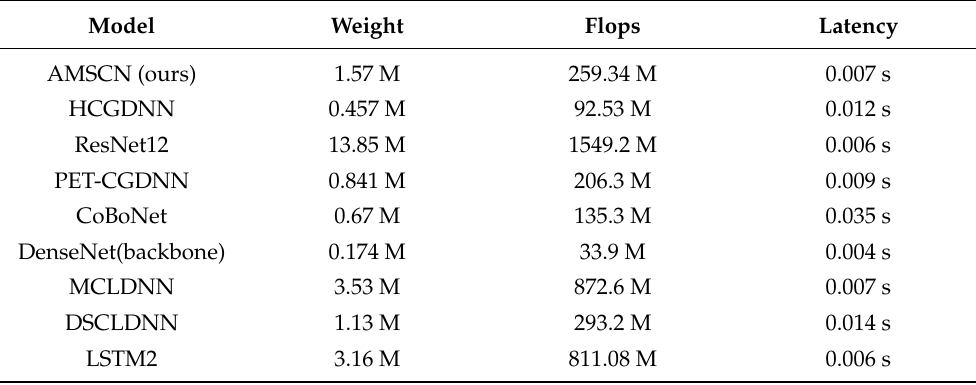
Table 5. Comparison of computational efficiency between models. The metric “Latency” stands for the inference time for a single signal sequence. If the two tasks are considered together, the weight and the calculated amount of all other models should be doubled. Model Weight Flops Latency AMSCN (ours) 1.57 M 259.34 M